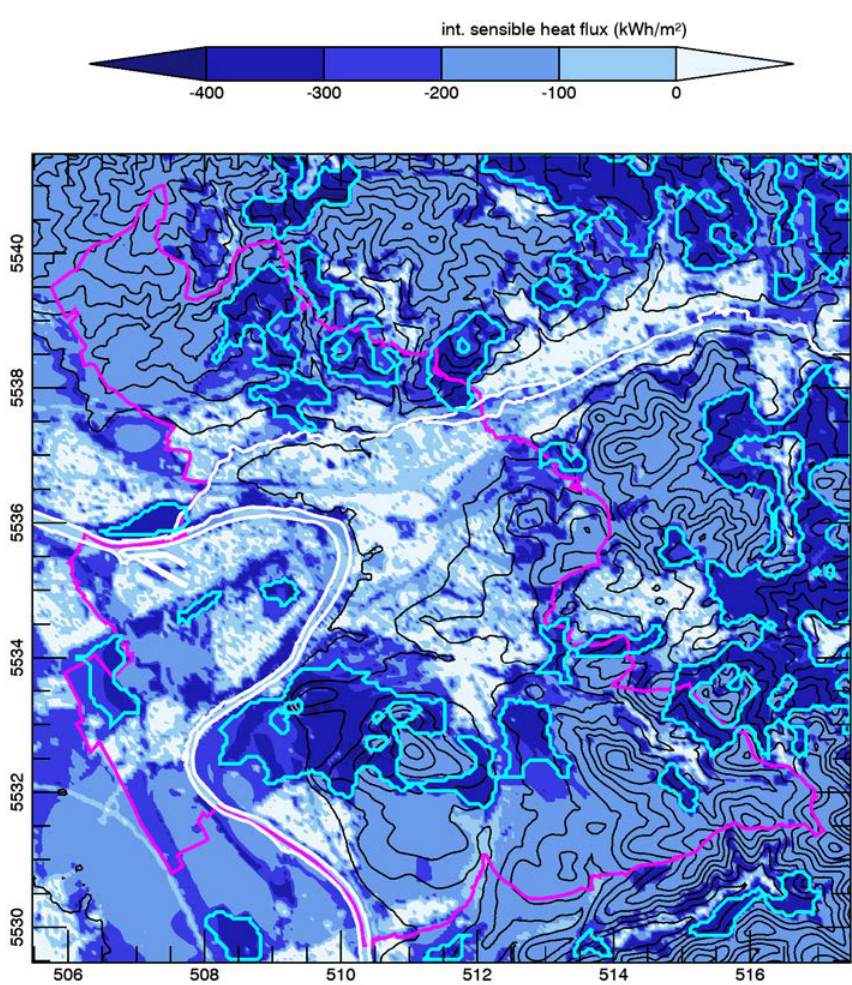
Figure 7. Map of the sensible heat flux (kWh/m²) between the ground and the atmosphere and between trees and the atmosphere integrated from 22:00 until 04:00 CEST (12 km × 12 km city subdomain). Cold air formation areas (CAs) delimitated by z-transformation are shown in cyan, the terrain elevation contour lines in black, the rivers in white and the city border of Aschaffenburg in magenta.